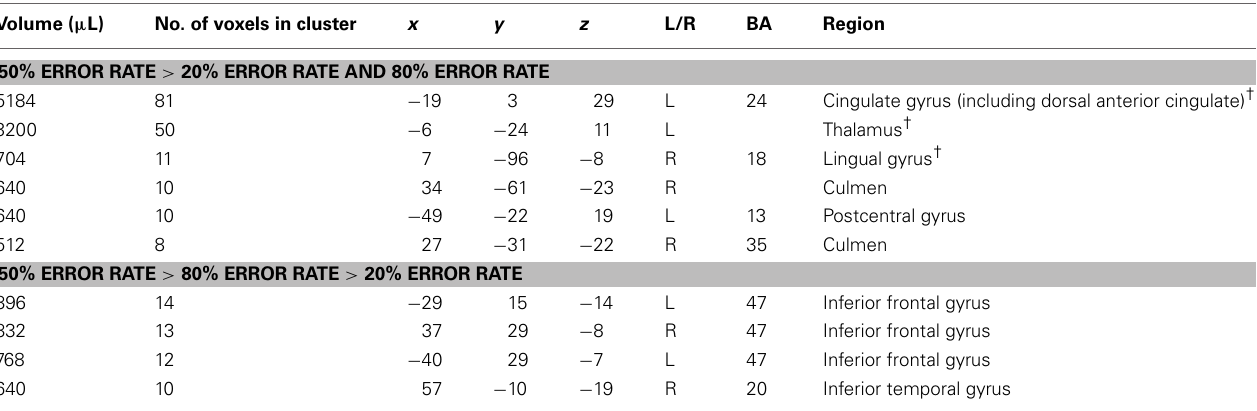
Table 3 | fMRI Results for the main effect of error